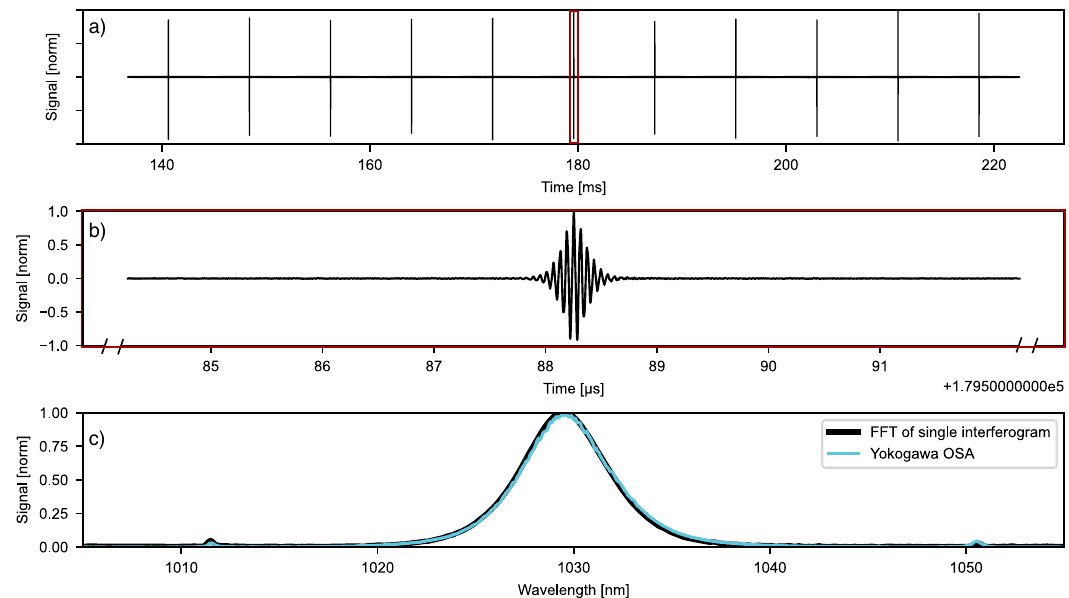
Fig. 4 Measurements with the dual-comb system without any sample. a Time-trace with 11 consecutive interferograms. Time separation between neighboring interferograms is 7.8 ms. b Single interferogram from center in ( a ). c FFT spectrum retrieved from a single 20 µ s time-trace shown in ( b ) and OSA reference spectrum. The spectral features (Kelly sidebands) around 1012 and 1052 nm are reproduced very well that con fi rms accuracy for a spectral span of Δ λ ¼